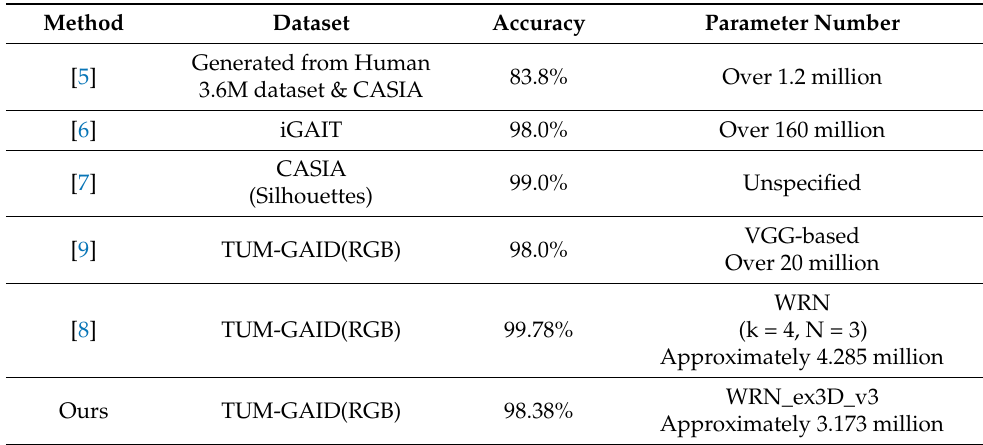
Table 10. Comparisons with related